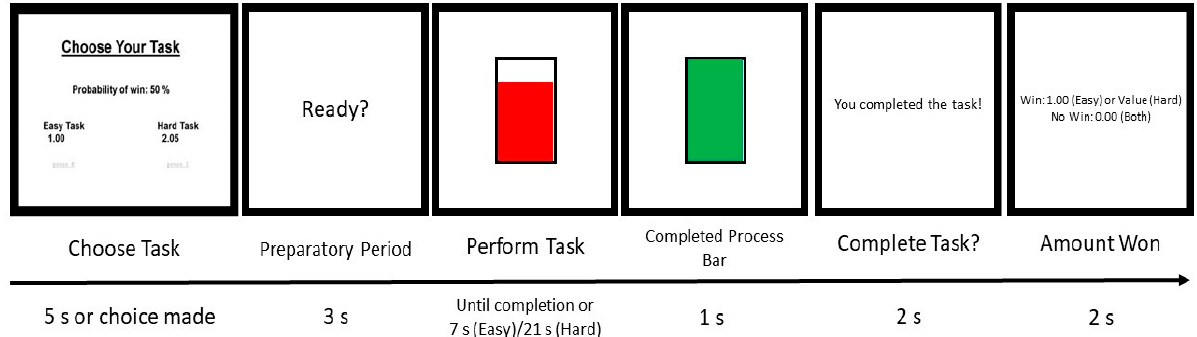
Figure 1. Stimuli presented to participants. The first screen prompts participants to choose to complete either an easy or hard trial based on the points that can be won and the likelihood of winning points given trial success. The second screen is presented for 3000 ms and allows participants to prepare for task execution. The third screen is presented during task execution; the red bar grows each time the participant presses the spacebar. The fourth screen is presented if the participant completes the desired number of spacebar presses successfully within the allotted time. The fifth screen informs participants of whether they successfully completed the trial. If the trial was completed successfully, the sixth screen informs participants of whether points were won (based on the probability of winning), as well as the quantity of points